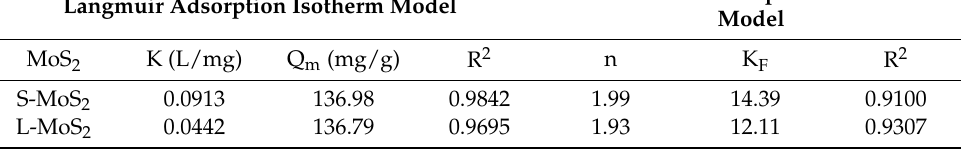
Table 1. Comparison of the maximum copper (II) ions adsorption capacities for various MoS 2 adsorbents from Langmuir